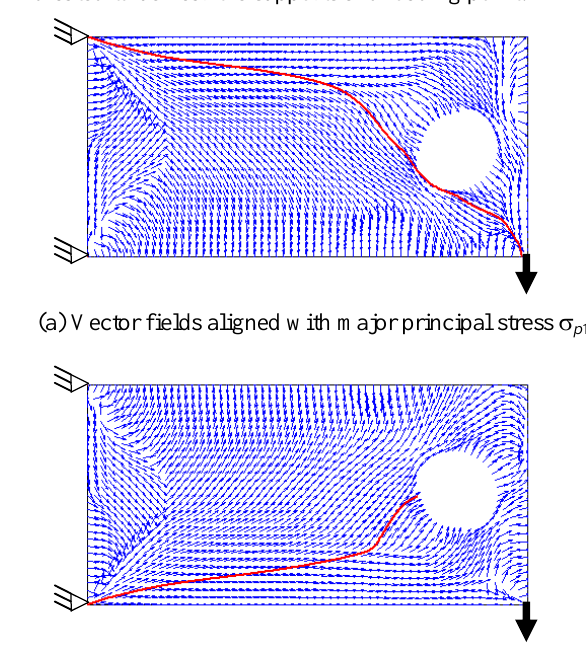
ector fields aligned with minor principal